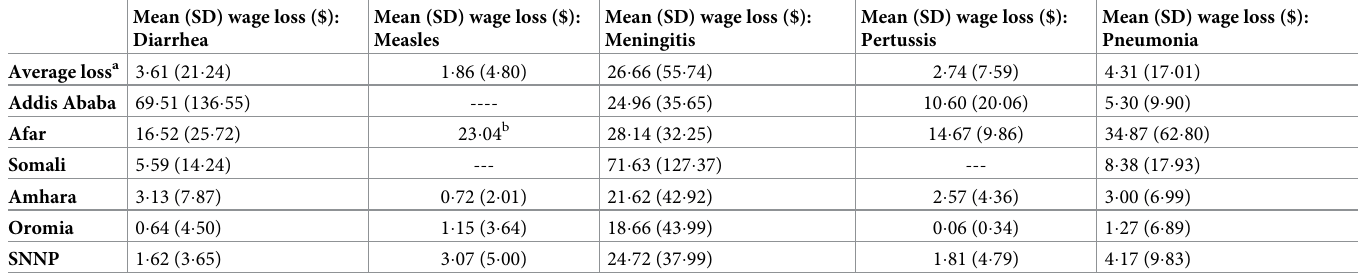
Table 3. Estimated mean income or wage losses (in 2021 USD) per illness episode for combined inpatient and outpatient care by disease type and region. Mean (SD) wage loss ($): Mean (SD) wage loss ($): Mean (SD) wage loss ($): Diarrhea Measles Meningitis